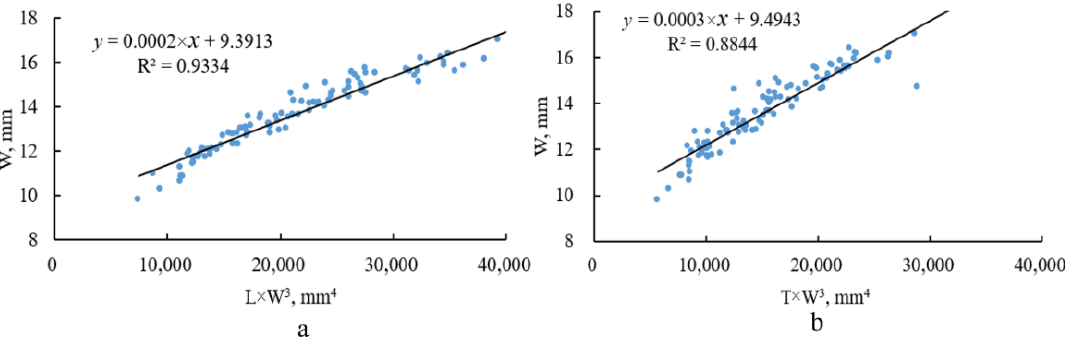
Figure 7. Relationships between two dimensions of Jinong 3 seeds: ( a ) width–length and ( b ) width–thickness. Table 3. Relationships between the primary dimension and the secondary dimensions of different varieties of Cyperus esculentus seeds.